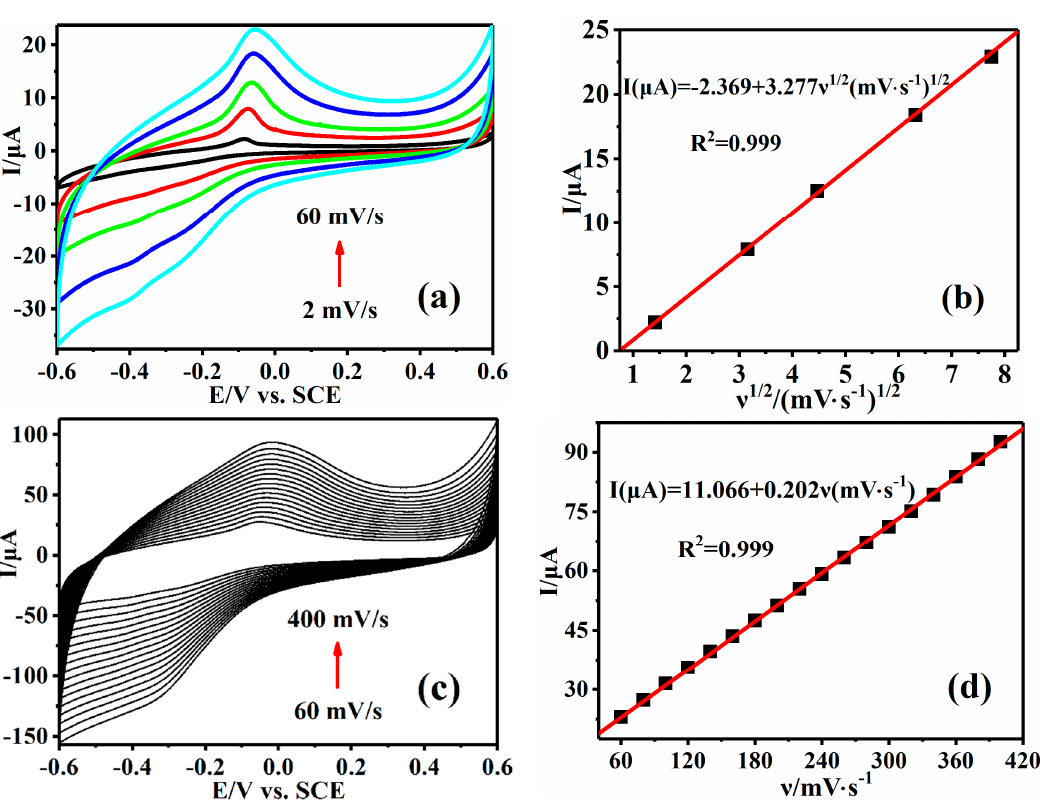
Figure 4. ( a ) CVs of Cu-TCPP@MOFs/GCE in 1.25 mM AA in PBS (0.1 M, pH = 7.0) under